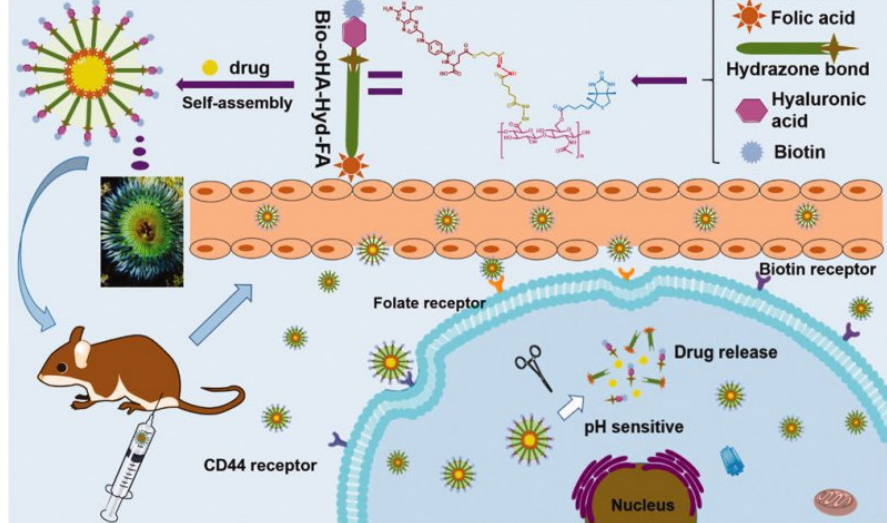
Figure 8. Scheme of the concept of cell uptake and drug release from Bio-oHA-Hyd-FA carriers. With permission from Tomeh et al. [200].